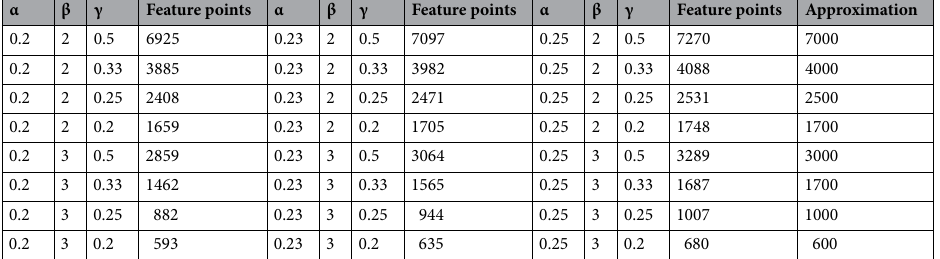
dicted feature images, there are three parameters α , β and γ together constraining the feature point extraction effect. α controls the threshold of the predicted grayscale feature image to decide whether each pixel belongs to the feature line. β controls the width of the feature line. γ controls the spatial size of each feature pixel in the 2D image corresponding to the 3D model. The influence of different parameters for extracting feature points of the 3D point cloud (bunny for instance) is shown in Table 3: Table 3 shows that different parameters have different effects on extracting the feature points. The change of α has little effect on the number of feature points, while β and γ bring great difference. Figure 10 shows the feature extraction results of bunny with approximate feature points. It can be seen that the point clouds are too sparse in Fig. 10e–g, and the contours are not complete enough to cover all feature points. However, (a) has too many points and does not meet the requirements of simplification. The ears in (c) and (d) are not perfect, and there are holes in both. In contrast, (b) shows best among them, not only retaining the contour points, but also showing more details such as ears, neck and bottom. Therefore, we select the parameters with the number of feature points around 4000. There are three groups of such parameters in Table 3, α = 0.2, β = 2, γ = 0.33 ; α = 0.23, β = 2, γ = 0.33 and α = 0.25, β = 2, γ = 0.33 . A series of experi- ments on other models with these parameters are carried out and it indicates that the results are most stable with parameters α = 0.23, β = 2, and γ = 0.33 . Therefore, we adopt α = 0.23, β = 2, and γ = 0.33 as the optimal ones. The feature point extraction results obtained with these optimal parameters are shown in Fig. 11.